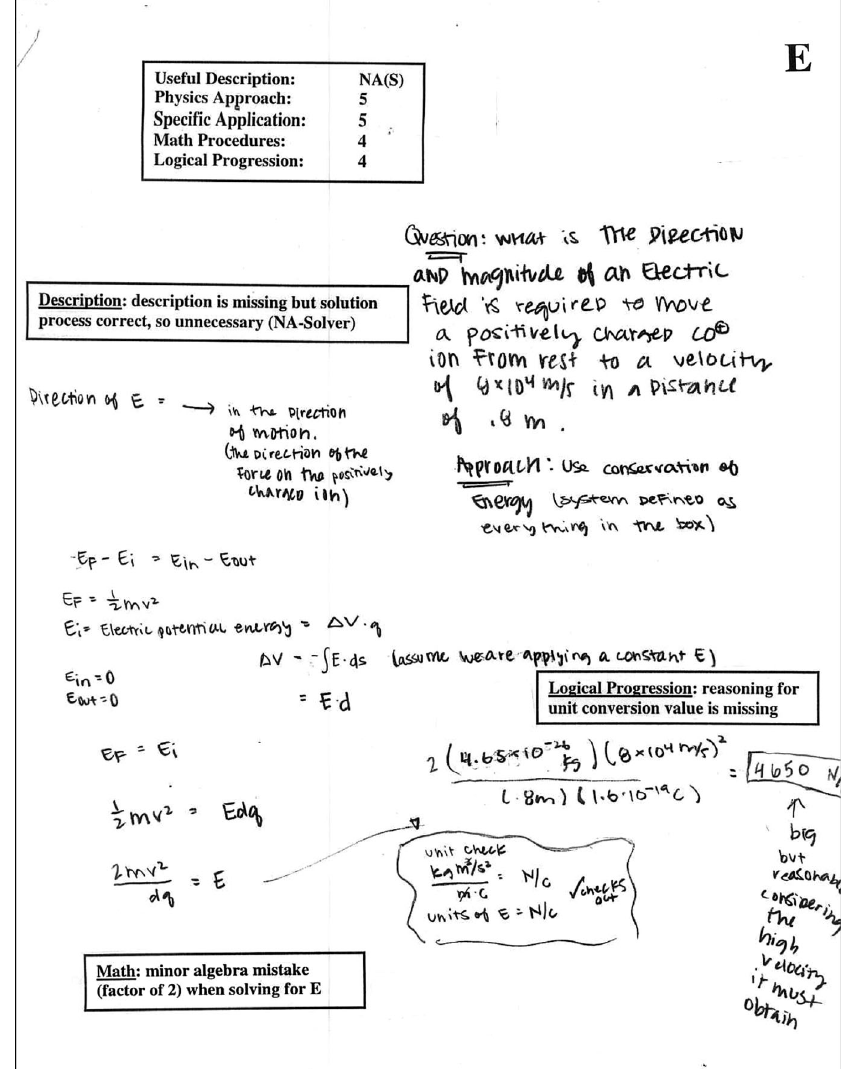
FIG. 2. Example of applying the MAPS rubric to a student